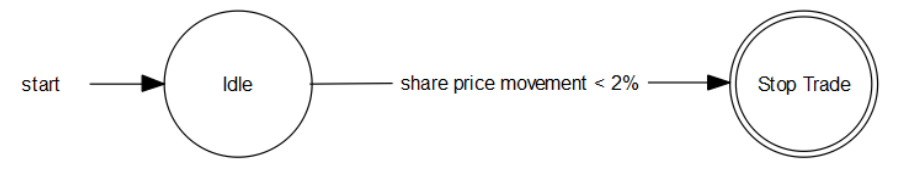
Fig. 4. Example for an excluded transition of the Non-Player Character Finite State